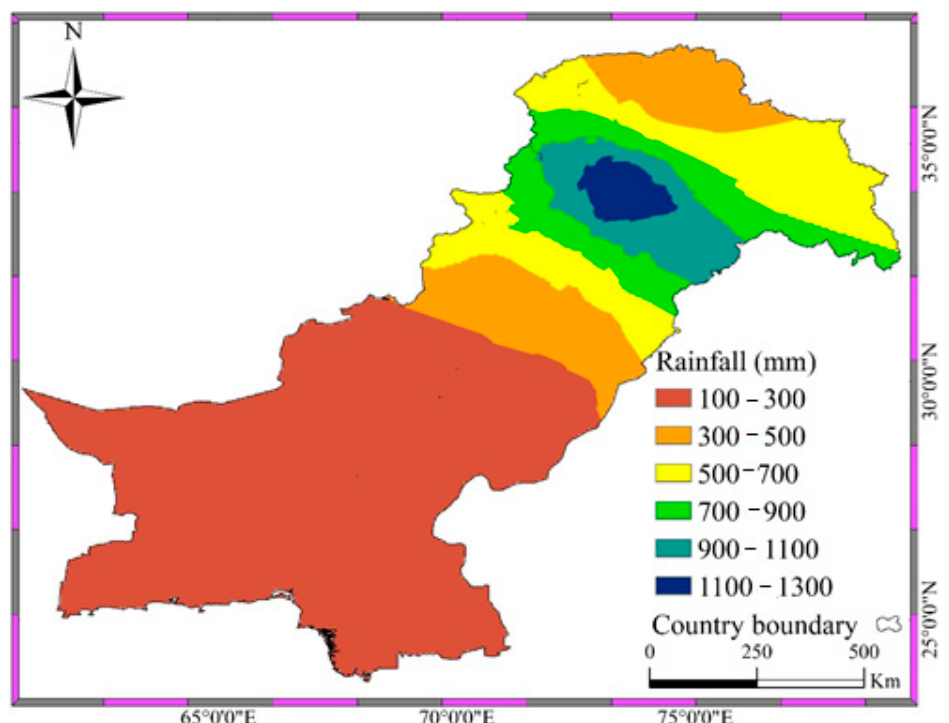
Figure 2. Spatial distribution of average annual precipitation (based on data from 2010 to 2018) in Pakistan.